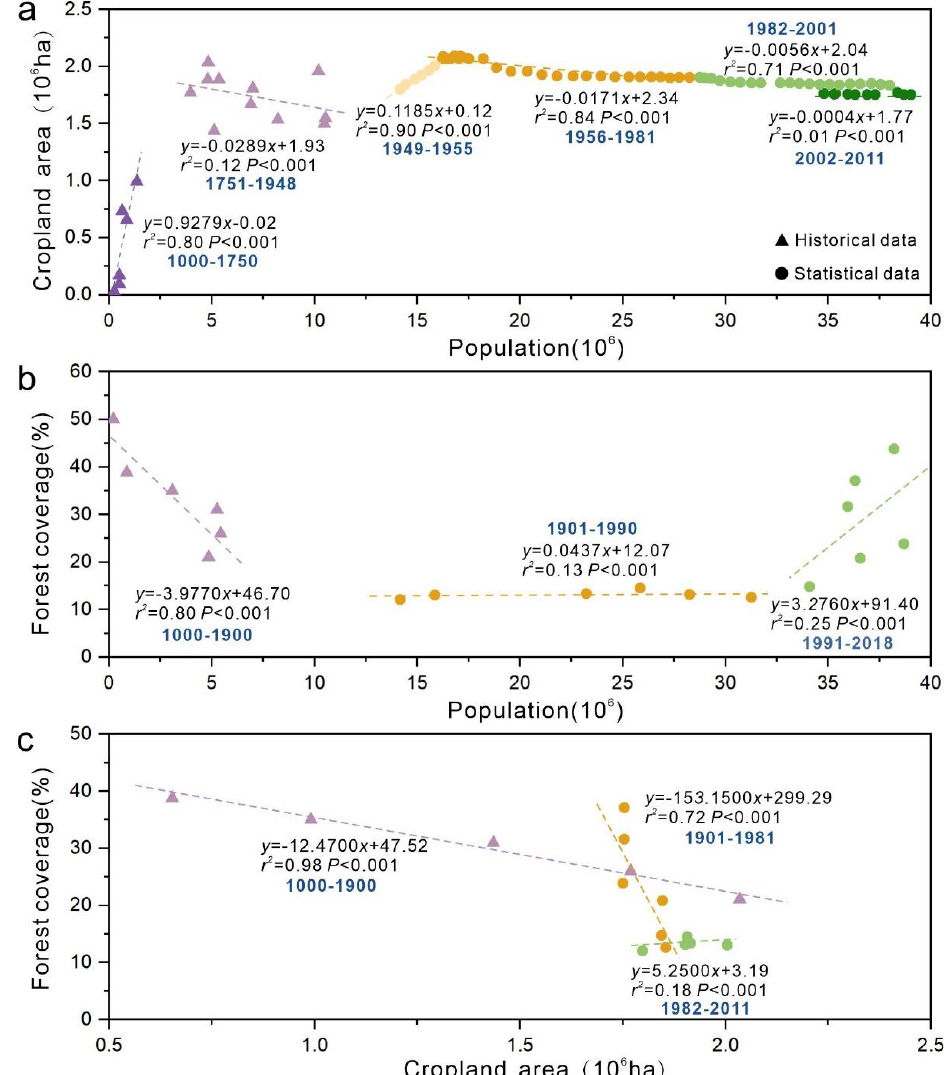
Figure 5. Changes in interactions between SES components of Guizhou Province. ( a ) Relationship between population and cropland area. ( b ) Relationship between population and forest coverage. ( c ) Relationship between cropland area and forest coverage.